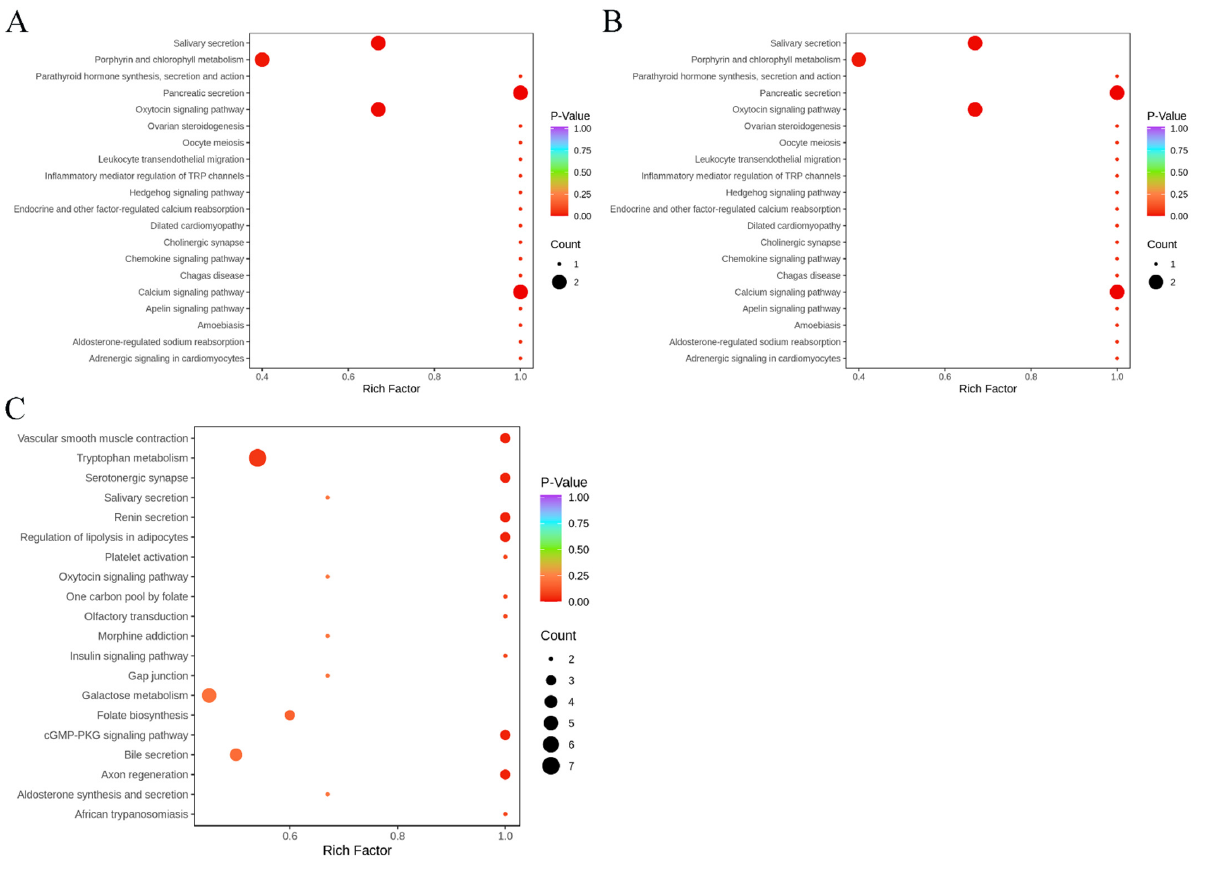
Figure 5. KEGG annotations and enrichment of differentially expressed metabolites of each pairwise comparison of larvae. ( A ): CK-5d vs. 20E-5d; ( B ): CK-6d vs. 20E-6d; ( C ): CK-7d vs. 20E-7d.